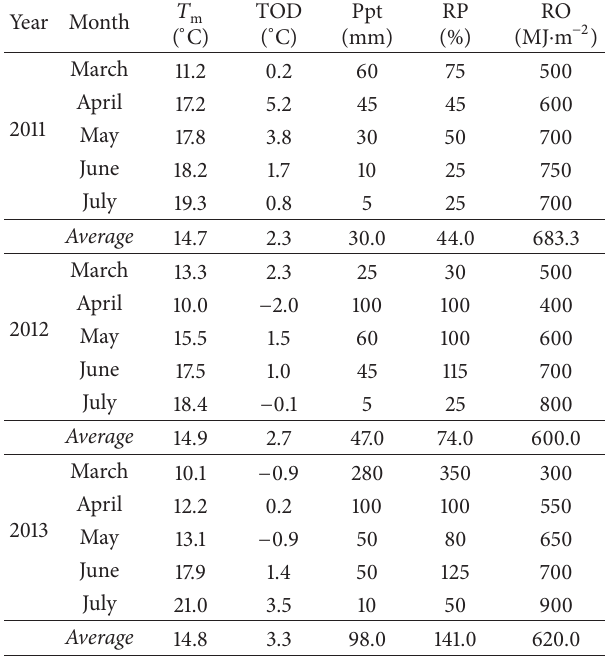
Table 1: Monthly acquired meteorological data in the growing season from March to July for Sever do Vouga in the period 2011– 13.